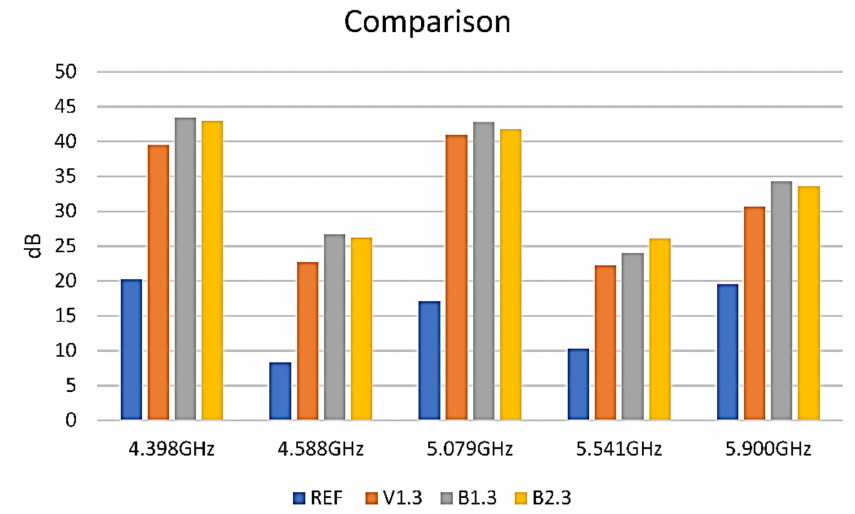
Figure 11. EMI-shielding measurements on 3 layers of each paint studied.